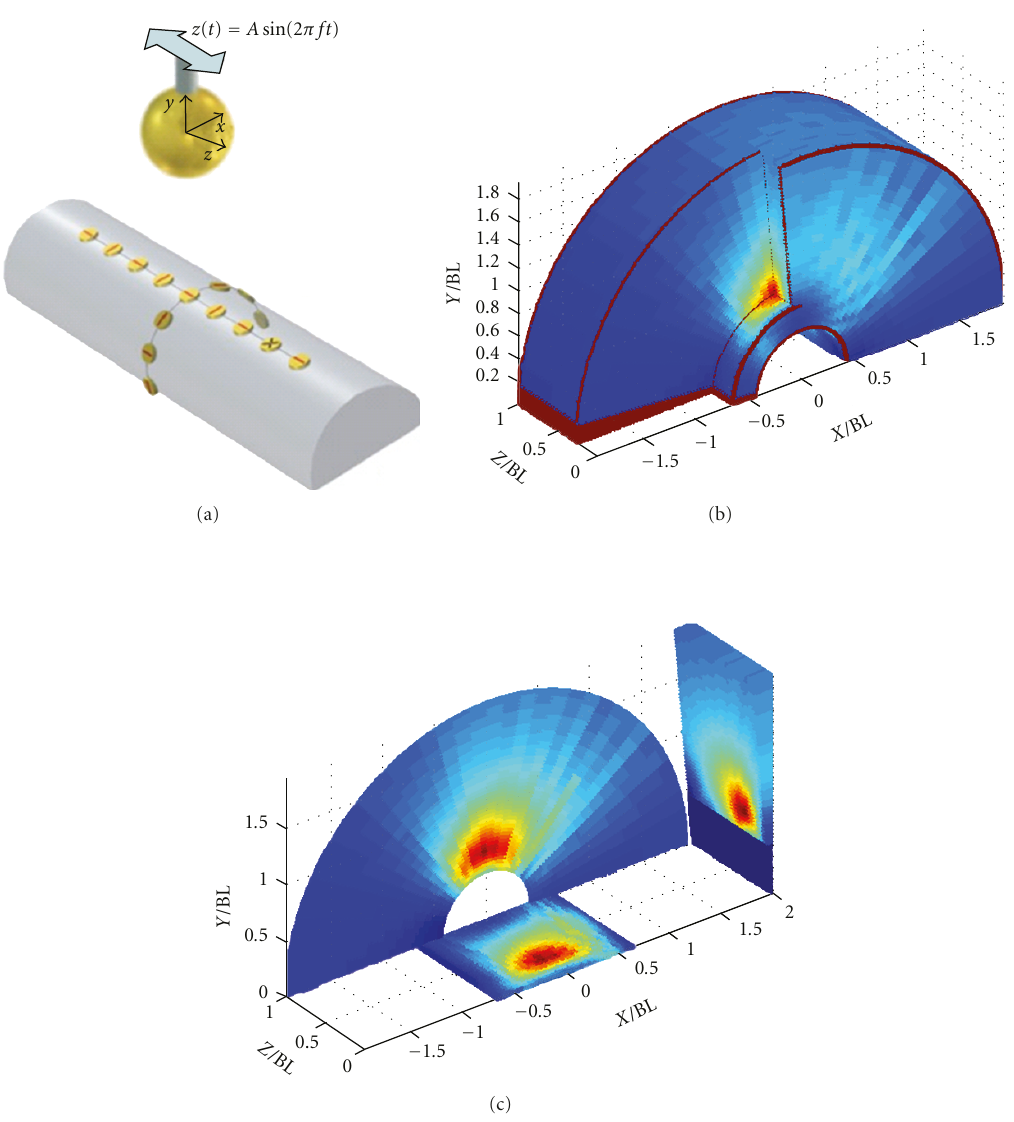
Figure 4: A 3D energy-like image of a dipole source at the central position and vibration along the cylinder. (a) A model of the sensor array with a dipole on the top of the central sensor. (b) A 3D image mapping the location of the dipole in space. (c) Projections of the result in (a) by sliding through the estimated dipole location along di ff erent